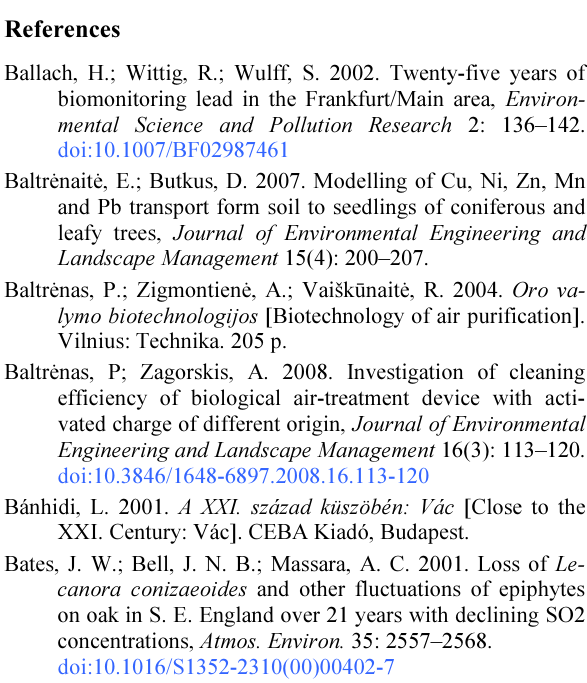
Fig. 5. The concentration of zinc, lead and iron in the leaves samples in the three types ecosystem (mg/kg